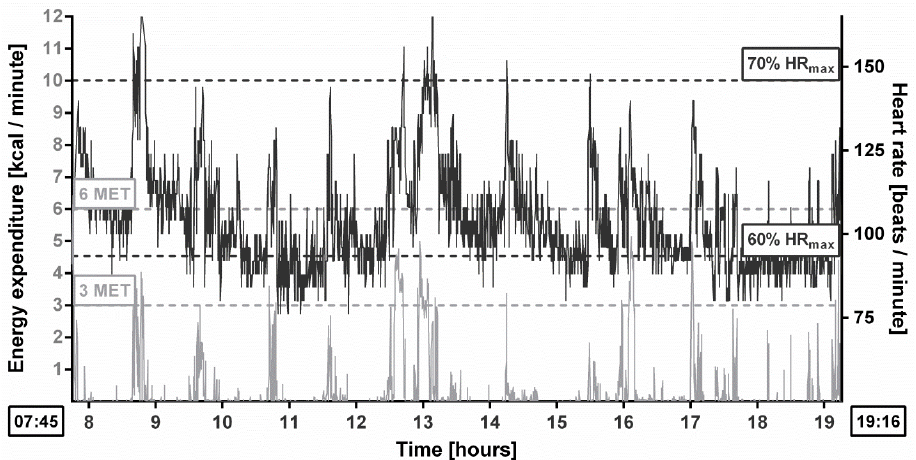
Figure 1. Example of individual feedback.